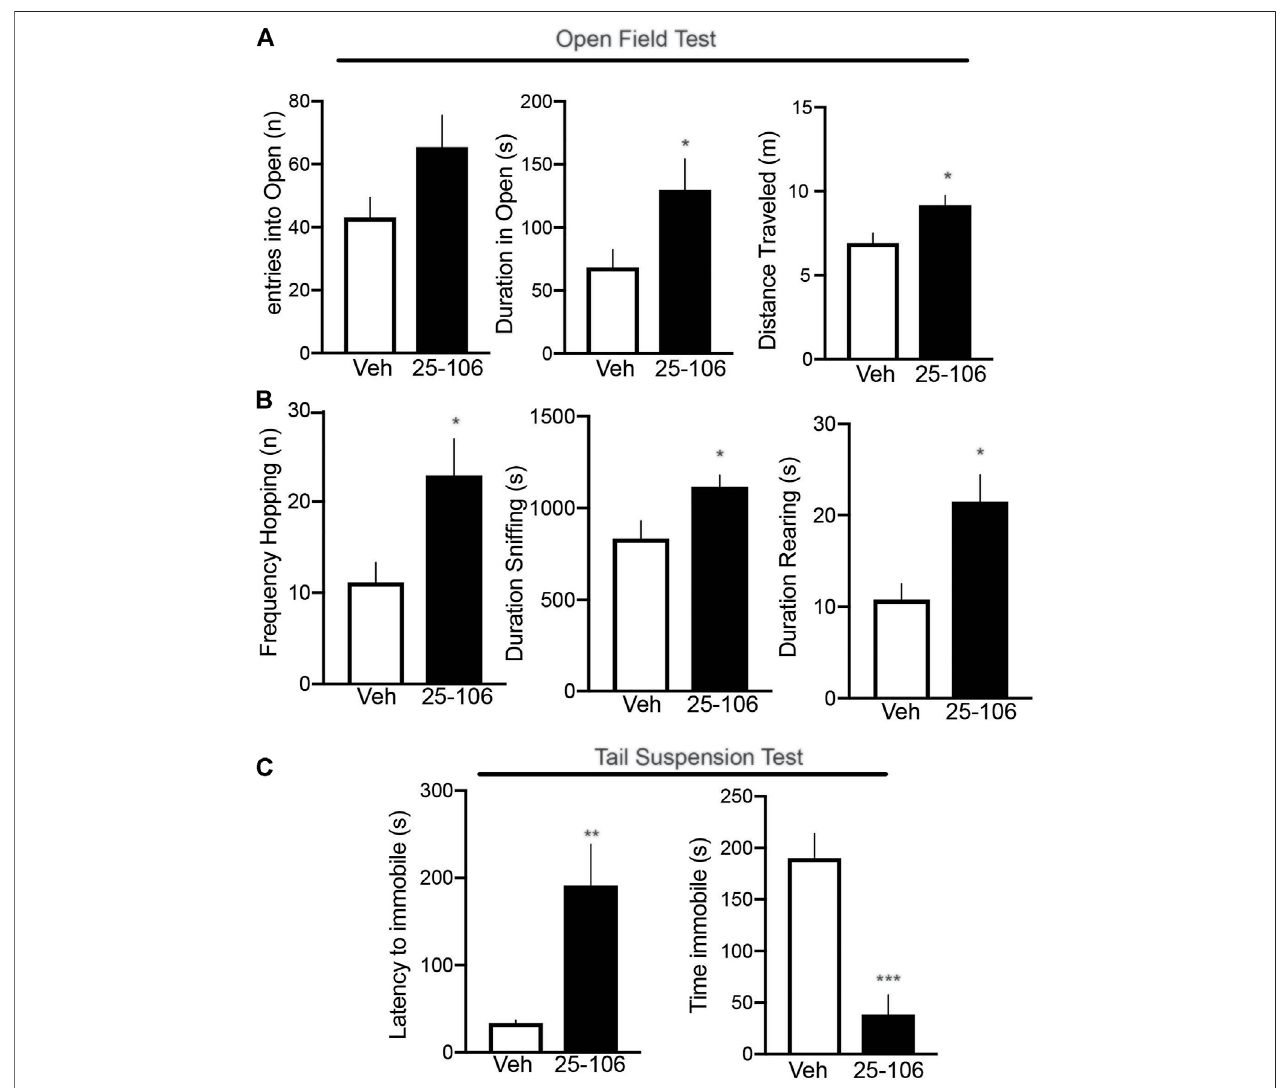
FIGURE7| Neurobehavioraleffects ofsystemic Cdk5inhibition. (A) Open- fi eldtesting( n =10 – 12pergroup)inmicetreatedwithvehicleor(50 mg/kg)25 – 1061 h afterinjection.Parametersdisplayedincludeentriesintotheopen,durationintheopen,anddistancetraveled. (B) Stereotypicbehaviorswereassessedduringtheopen- fi eld testing. (C) Effect of systemic 25 – 106 (50 mg/kg) treatment vs. vehicle on behavioral responses in the tail suspension test ( n = 11 per group) in vehicle or 25 – 106 – treated mice 6 h s after injection. * p < 0.05 Student ’ s t -test, ** p < 0.01 student ’ s t -test, and *** p < 0.001 student ’ s t -test.